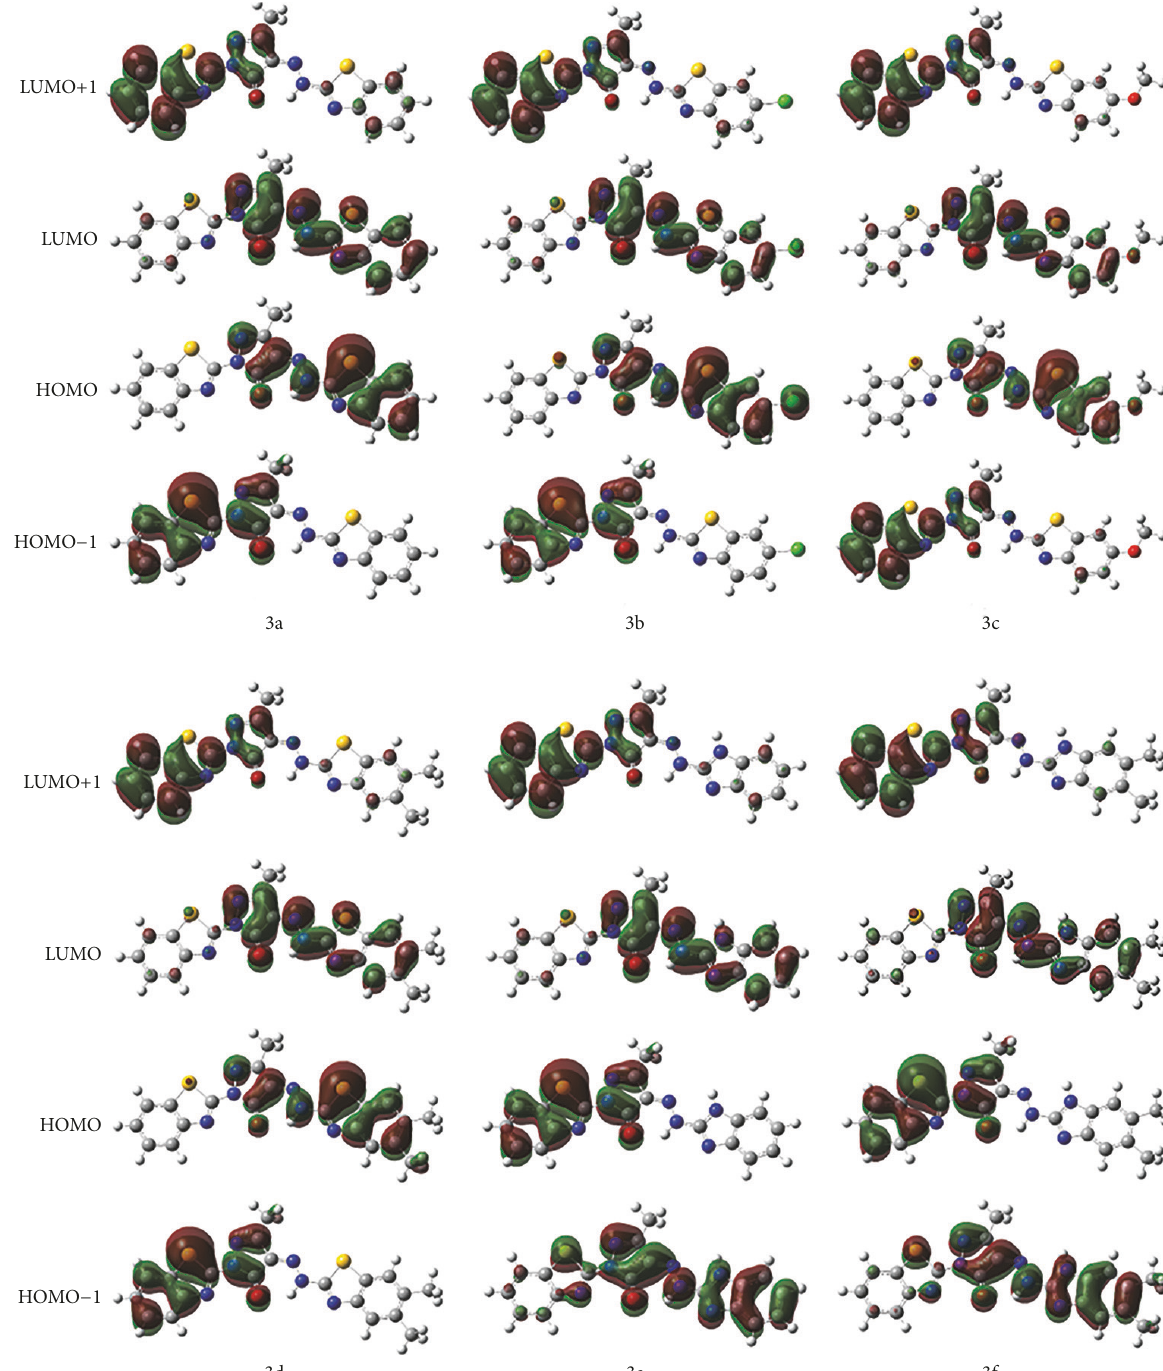
Figure 7: The frontier molecular orbitals of the dyes